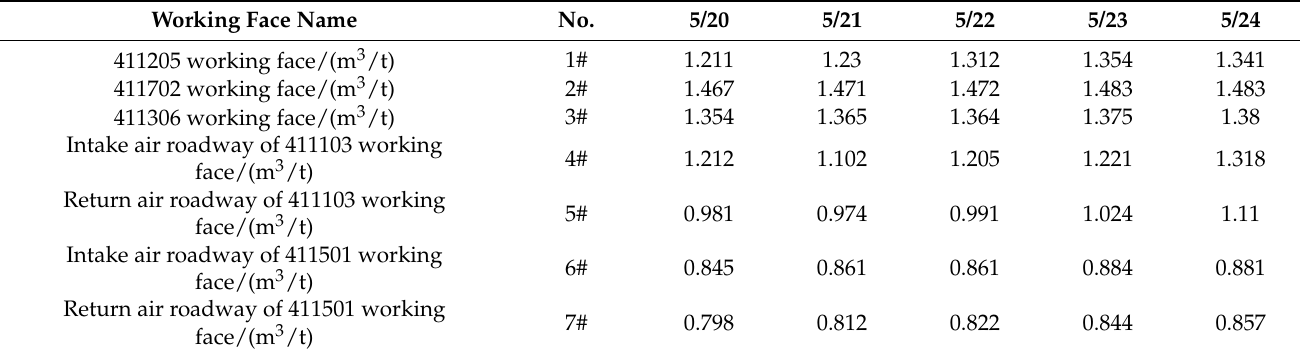
Table 1. Actual measured value of gas emissions in each working face.